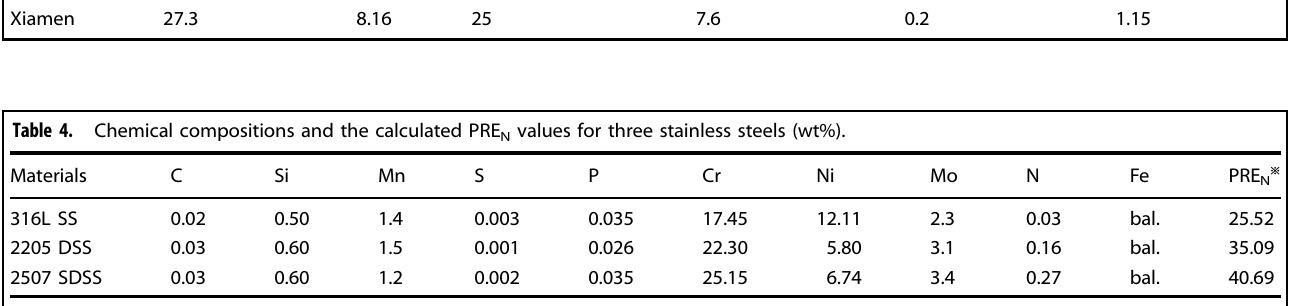
Table 3. Physicochemical properties of seawater at the fi eld test site. Location